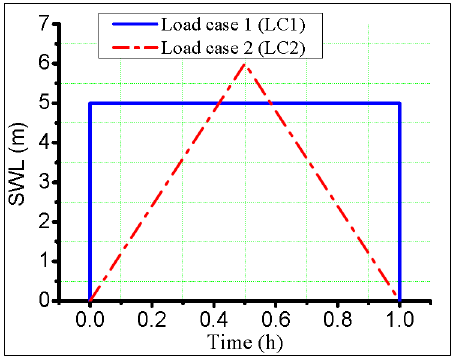
Figure 2 . Synthetic cases of the sea water level (SWL) rise under the effects of both meteorological and astronomical tides during the simulation interval (1.0